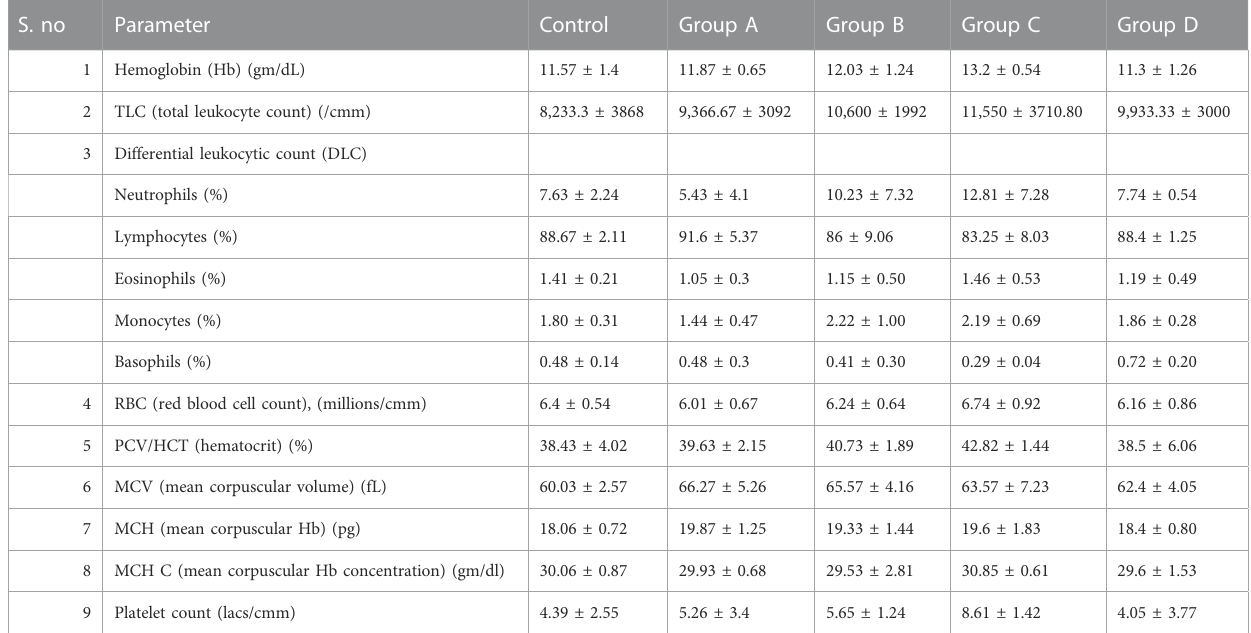
TABLE 2 Hematology pro fi le of rats after 14 days of oral NVA-IT administration. S. no